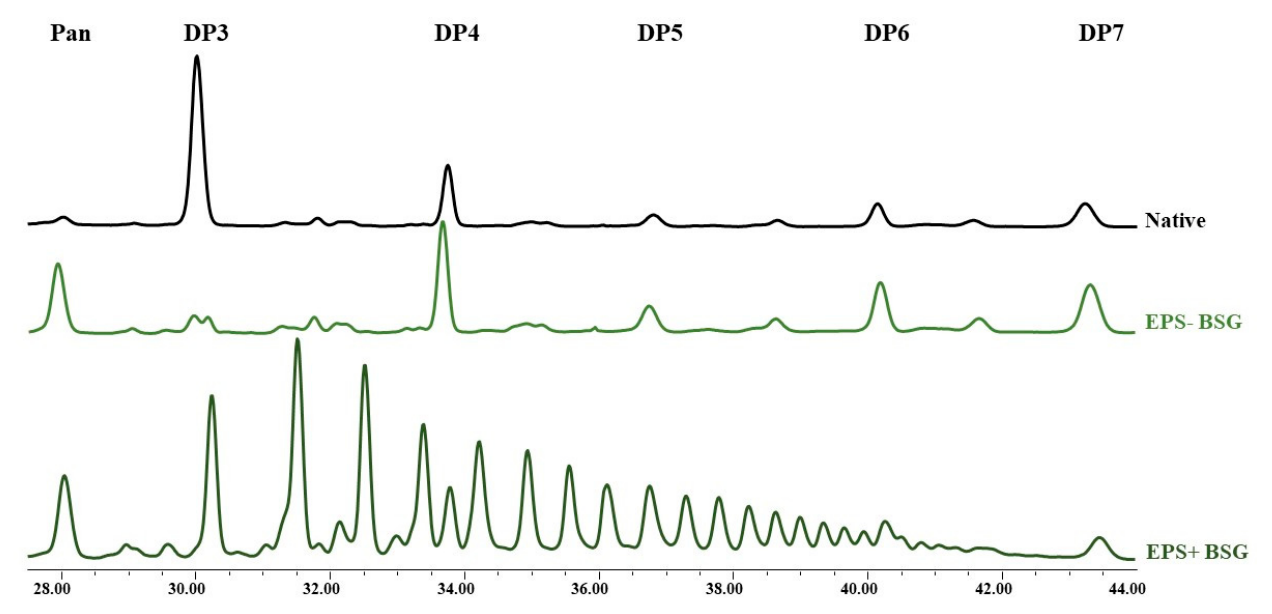
Figure 1. Chromatograms (obtained from HPAEC-PAD) of malto-oligosaccharides present in native BSG produced during fermentation of BSG without addition of sucrose (EPS-BSG) and malto-oligosaccharides equivalent maltosyl-isomaltooligosaccharides produced during fermentation of BSG with addition of sucrose (EPS+BSG). X axis denotes the retention time of different compounds. Profile of malto-oligosaccharides and MIMO present in native and fermented BSG with (EPS+BSG) and without (EPS-BSG) sucrose. Reference oligosaccharides: panose (Pan), maltotriose (DP3), maltotetraose (DP4), maltopentaose (DP5), maltohexaose (DP6) and maltoheptaose (DP7) were detected in all analysed samples.